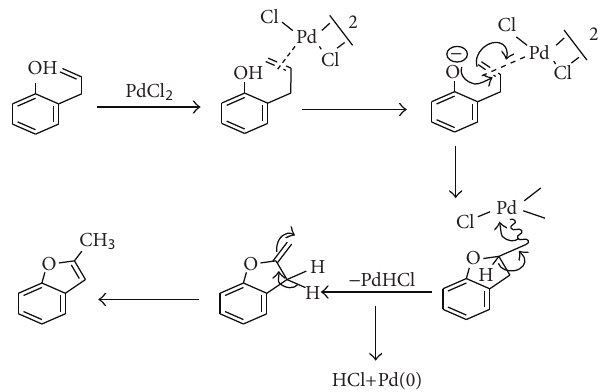
S 2: Mechanism of formation of 2-substituted benzofuran